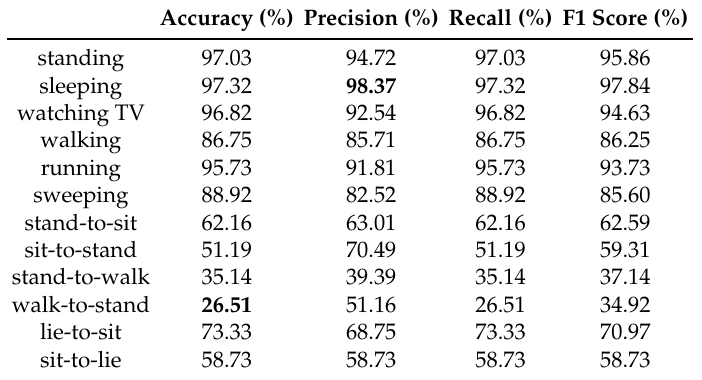
Table 3. Performance of each activity class recognition without